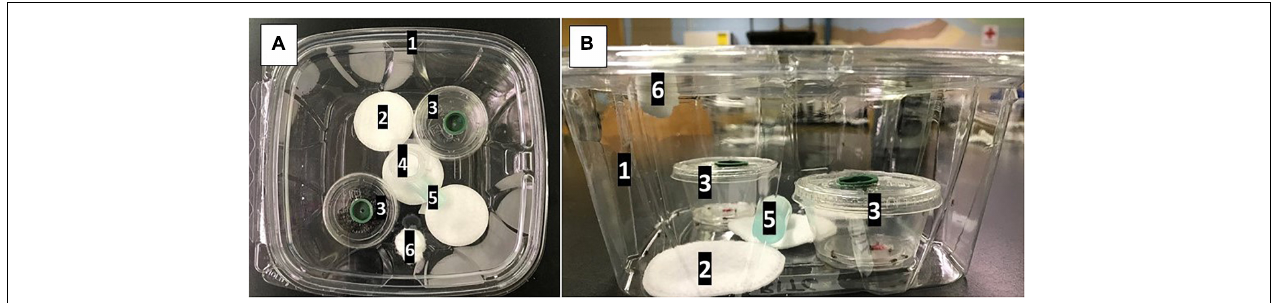
FIGURE 1 | The two-choice trap bioassay arena used in this study. (A) View from the top. (B) Side view. Components of bioassay arena include (1) a clear 1839 mL polyethylene container with lid, (2) moisturized cotton pads, (3) custom-made traps with treatment inside, (4) mesh-covered opening for air circulation, (5) a Drosophila suzukii water source, and (6) insect release point sealed with a cotton ball.